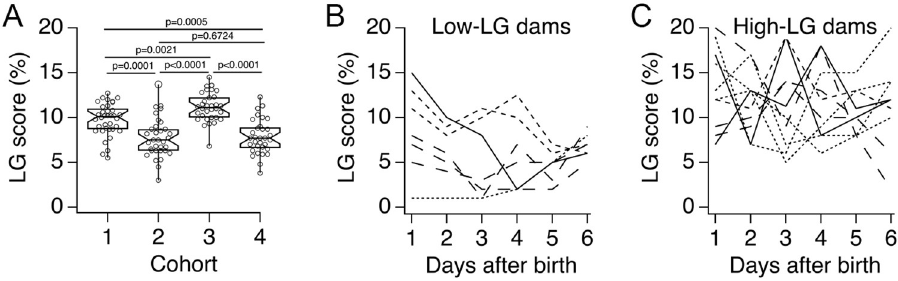
Fig 2. Variation of licking and grooming (LG) scores in selected dams. A , Box plots of six-day average LG scores from the four dam cohorts used in this study. Each circle represents one dam. P values were obtained by the Holm- Sidak’s multiple comparisons test. B , Daily LG scores for seven selected low-LG dams. C , Daily LG scores for ten selected high-LG dams. Continuous, dotted, short-dash and long-dash lines in B and C represent dams from cohorts 1, 2, 3 and 4,